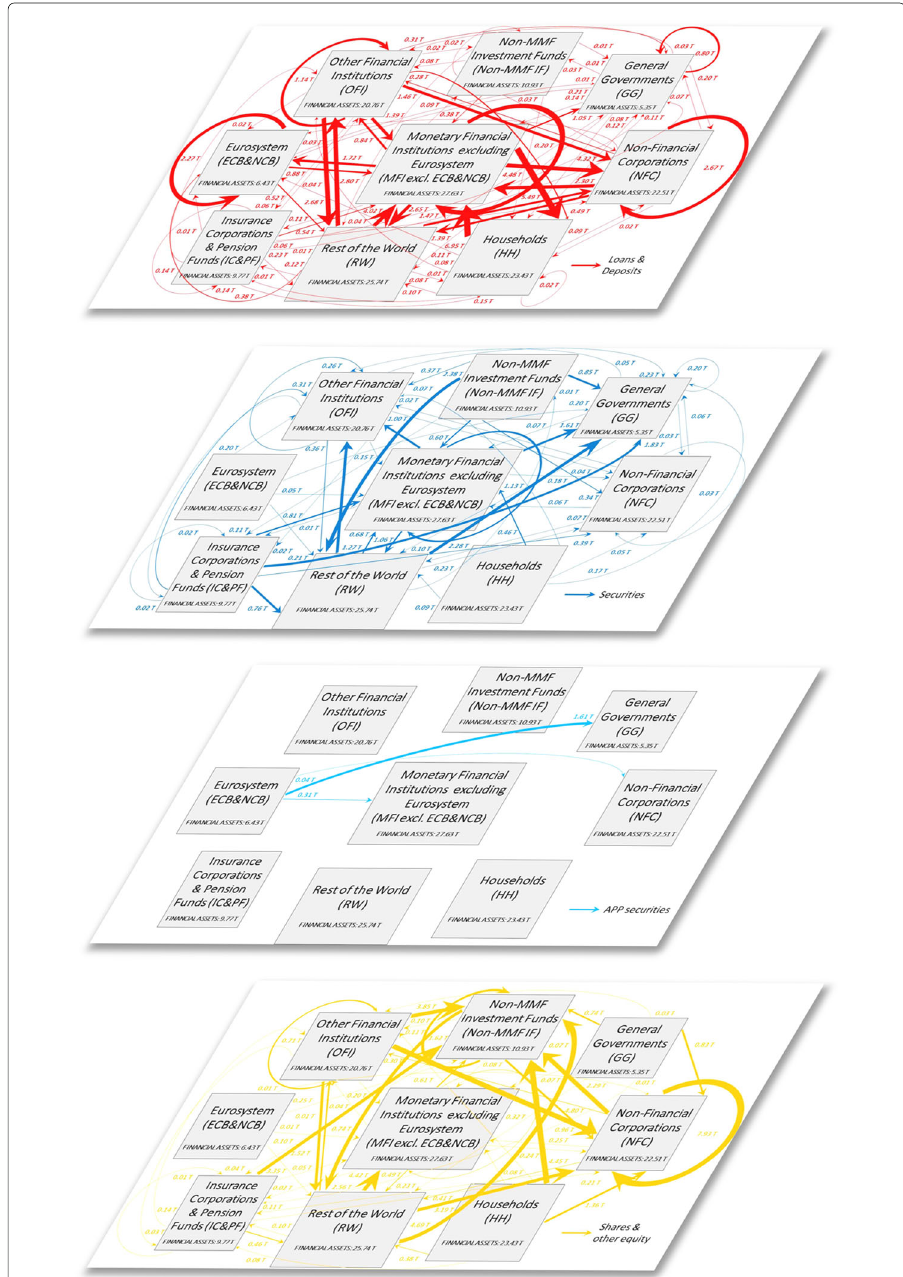
Fig. 2 The multilayer macro-network of financial exposures in the euro area; June 2017. Multilayer macro-network of financial exposures among the different institutional sectors operating in the euro area (i.e., Eurosystem (ECB&NCB), Monetary Financial Institutions excluding the Eurosystem (MFI excl. ECB&NCB), Other Financial Institutions (OFI), Non-MMF Investment Funds (Non-MMF IF), Insurance Corporations and Pension Funds (IC&PF), Households (HH), Non-Financial Corporations (NFC), General Governments (GG)), and the Rest of the World (RW), via i) loans and deposits (first layer, red links), ii) private and public debt securities (second layer, blue links), iii) APP securities (third layer, light blue links), and iv) shares and other equity (fourth layer, yellow links), with reference to the second quarter of 2017. Weights represent the outstanding financial exposures of a source institutional sector to a target institutional sector expressed in trillion euros. Data sources: European Central Bank (2017b) and European Central Bank